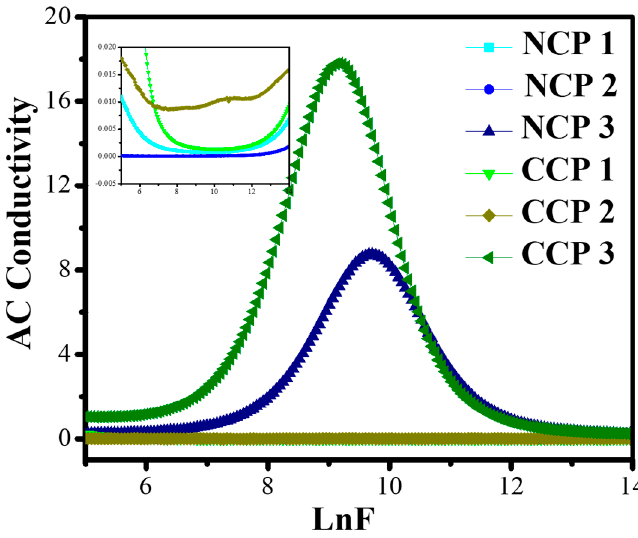
Figure 11. Variation in AC conductivity with varying concentrations of nanofillers at different